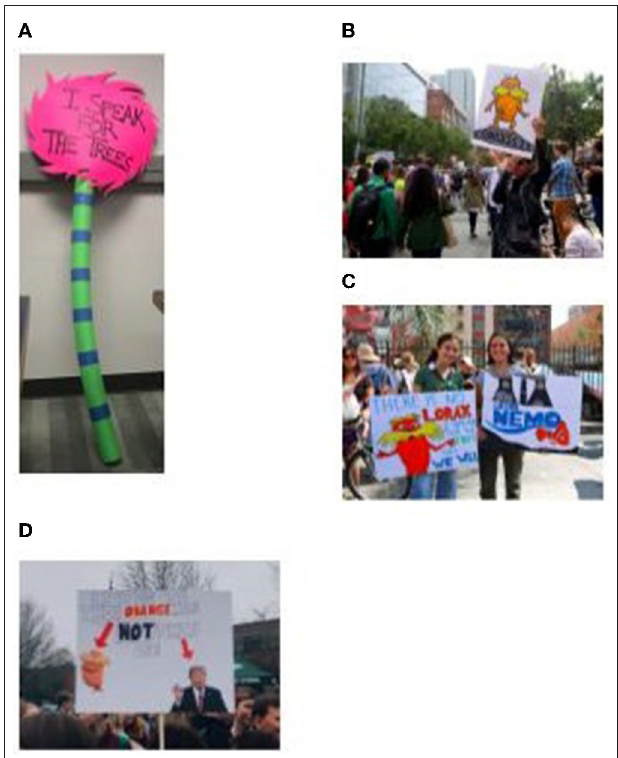
FIGURE 2 | The Lorax protests and posters. (A) Truffula Tree Sign (Schuenemann, n.d.). (B) FUnless sign (Daretoeatapeach, 2017). (C) Lorax and Nemo Poster ( Salinas, 2019). (D) Trump Poster ( Funny Video Memes, Funny Memes, Good Jokes , n.d.).